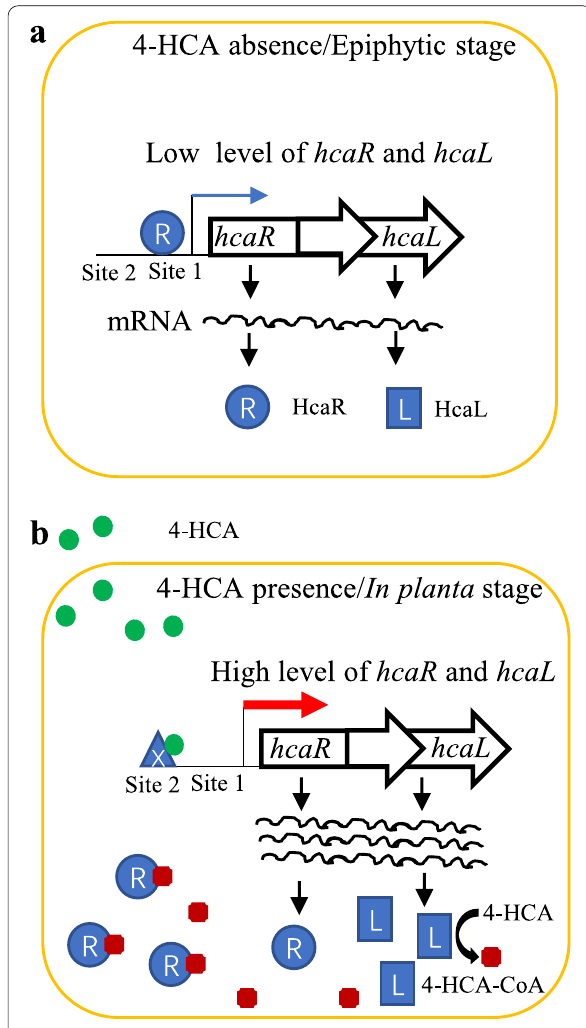
Fig. 8 A schematic working model for hca induction in Xcc . a In the absence of HCAs or at the epiphytic stage of infection, the hca gene cluster is transcribed at a low level. HcaR binds to site 1 of the hca promoter P hca to inhibit hca transcription. b In the presence of HCAs or during the in planta stage, HCAs are transported into the cytosol and bind to an uncharacterized HcaX, the resultant HCA/ HcaX complex binds to site 2 of P hca to increase hca transcription. The increased levels of HcaL catalyze the conversion of HCAs into HCA‑CoAs, which further bind to HcaR. The HCA‑CoA/HcaR complex then releases from the site 1 of P hca , further increasing the transcription level of hca . This is a self‑reinforcing process which eventually leads to very high levels of expression of the hca gene